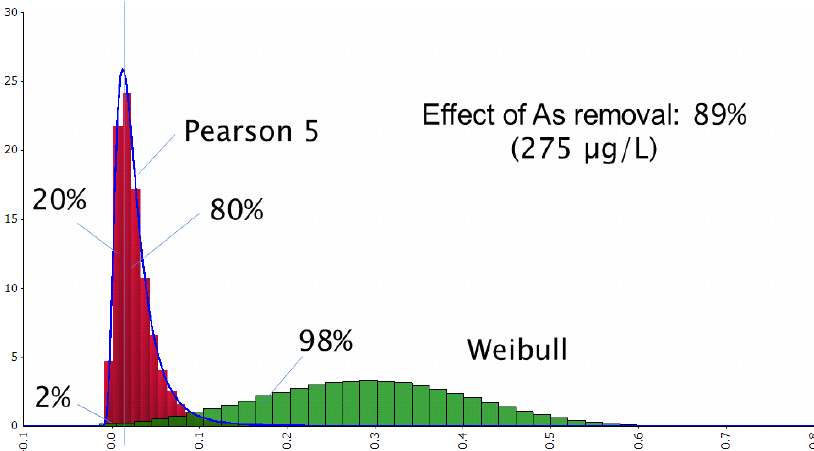
Figure 3. As concentrations in tube-well water before (green) and after (red) sand